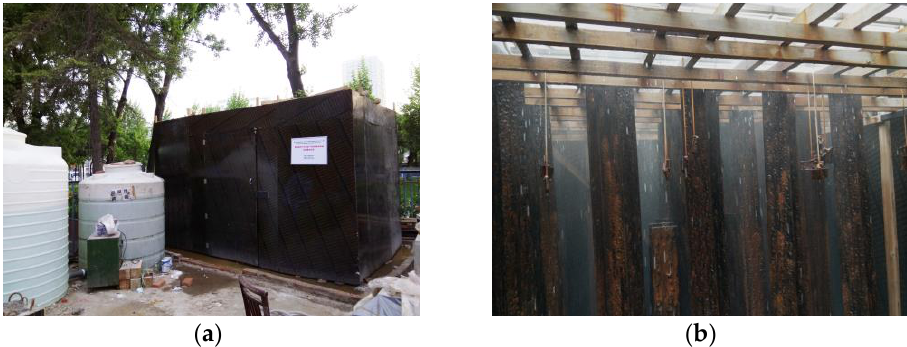
Figure 1. Accelerated corrosion test of H-beams: ( a ) general view of the test platform and ( b ) sche- matic diagram of internal sprinkler. ( b ) schematic diagram of internal